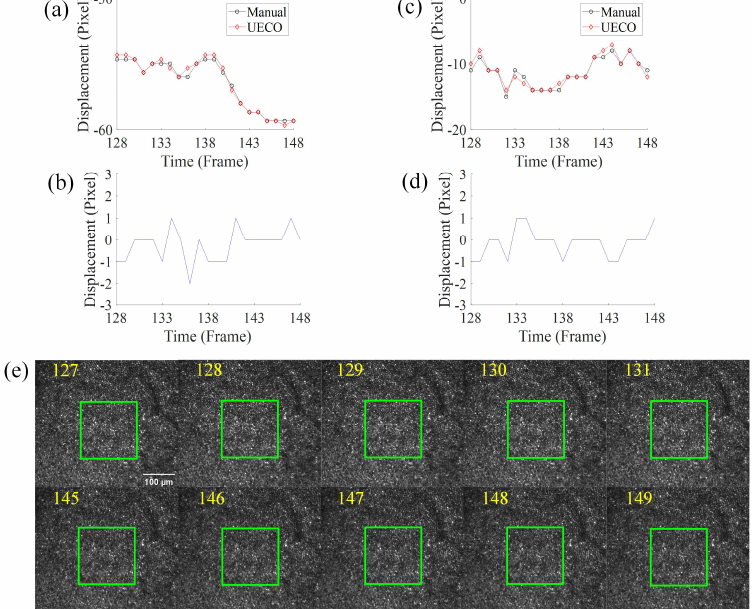
Figure 10. Comparison of displacement under slow drifts; ( a,c ) respectively show the comparison of vertical and horizontal displacement obtained by manual registration and UECO under slow drifts; ( b , d ) are the differences in the vertical and horizontal displacement between UECO and manual registration; and ( e ) is 10 frames in an image sequence of slow drifts. The green box is the UECO reference and the yellow text in the graph represents the current frame number. The frame number corresponds to the frame number in the original video. The scale bar is 100 µm.